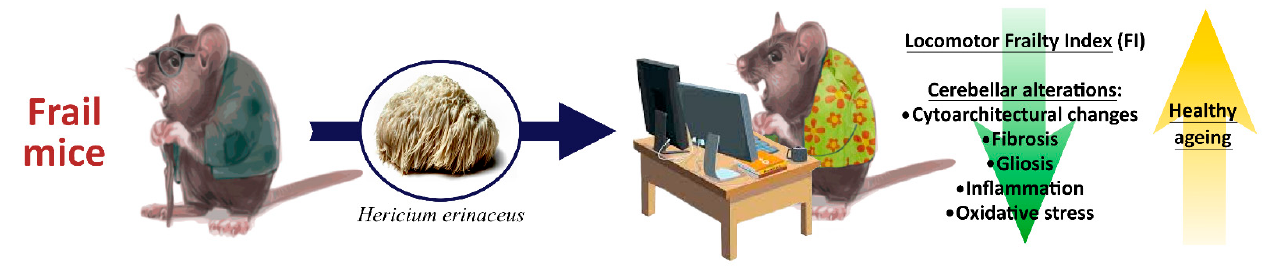
Figure 15. Schematic illustration summarizing main findings and the take-home message of the manuscript.